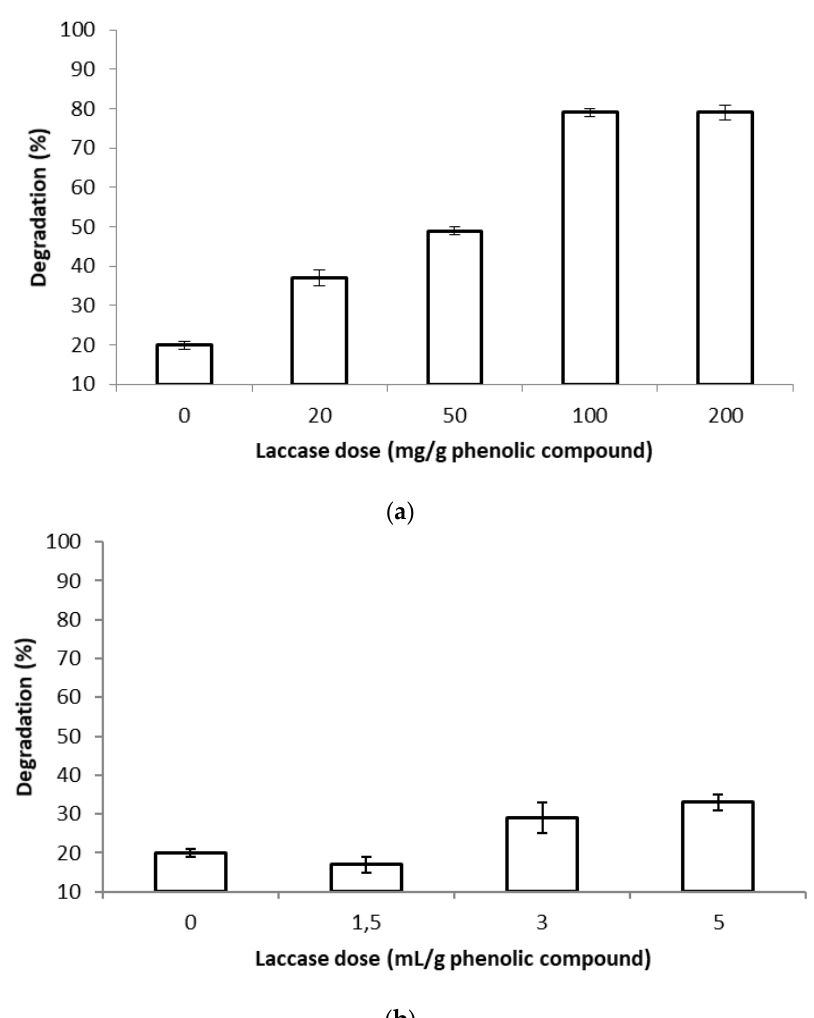
Figure 3. Degradation of phenolic compounds with different dose of laccase enzymes: ( a ) solid laccase; ( b ) liquid laccase.